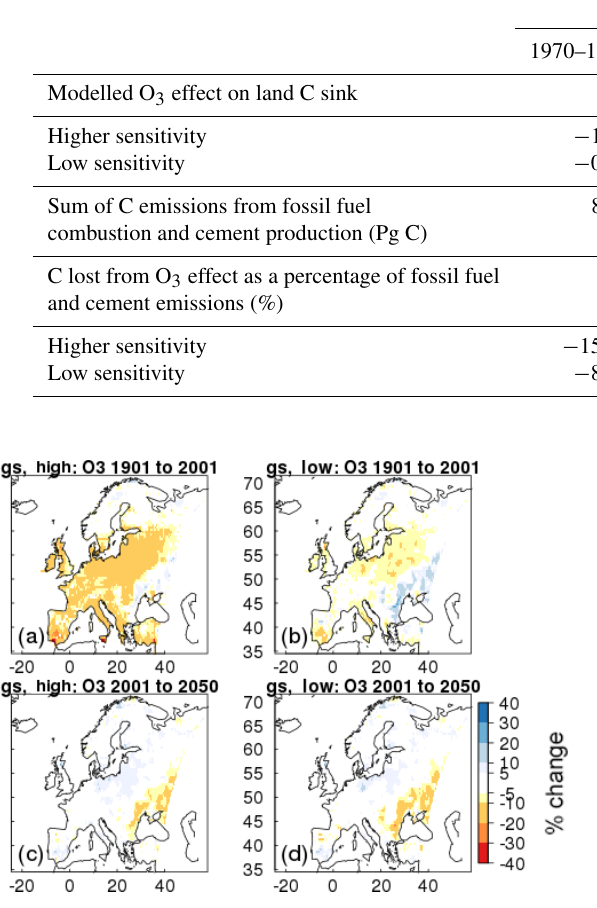
Figure 6. Simulated percentage change in stomatal conductance ( g s ) due to O 3 effects at the fixed pre-industrial atmospheric CO 2 concentration (run_O 3 ). Changes are shown for the periods 1901 to 2001 and 2001 to 2050 for the high and low plant O 3